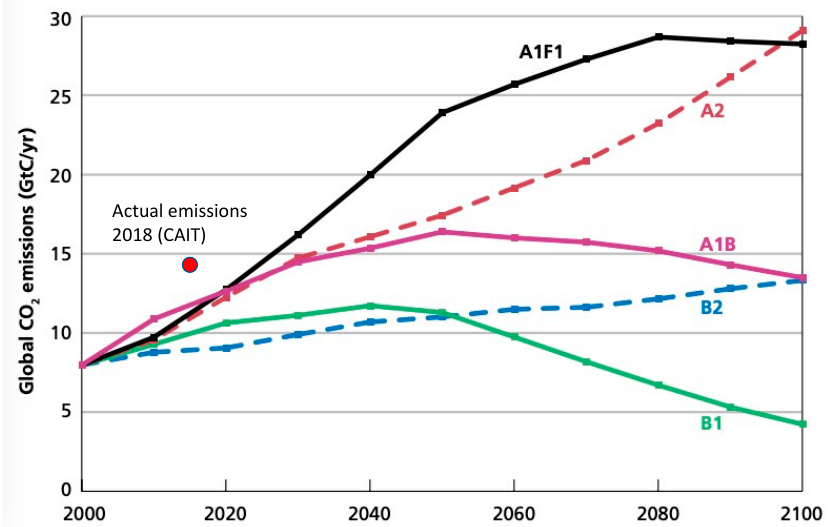
Figure 1. Global annual CO 2 emissions (expressed as gigatonnes of carbon equivalent) under the three IPCC SRES marker scenarios used in UKCP09: A1FI (black: high emissions), A1B (purple: medium emissions), and B1 (green: low emissions). Additionally shown dotted are two SRES emissions scenarios used in UKCIP02 but not in UKCP09: A2 (red: medium–high emissions) and B2 (blue: medium–low emissions). Reproduced from Figure 2.13 [28]. Red dot shows actual 2018 emissions from the Climate Watch website [34], CAIT dataset (3-year lag), in GtC/y, added by